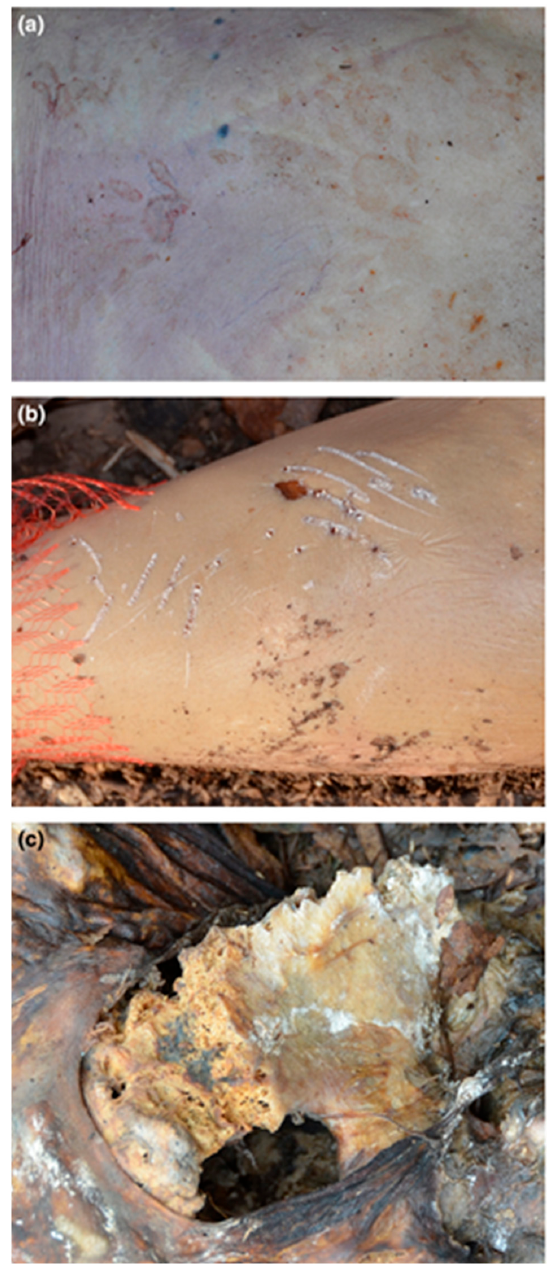
Figure 7. Experimental raccoon-scavenged human remains showing ( a ) paw prints on the back skin, ( b ) scratch marks on a leg and ( c ) gnawing damage to an innominate bone. Reproduced with permission from Jeong et al. [123]; published by Elsevier, 2016. Primary access by raccoons to the human bodies starts at limbs, mainly by opening the skin via small, oval perforations. Further locations include the feet, face, and genitalia, followed by the abdomen [4]. Lower limbs were scavenged more frequently, and before